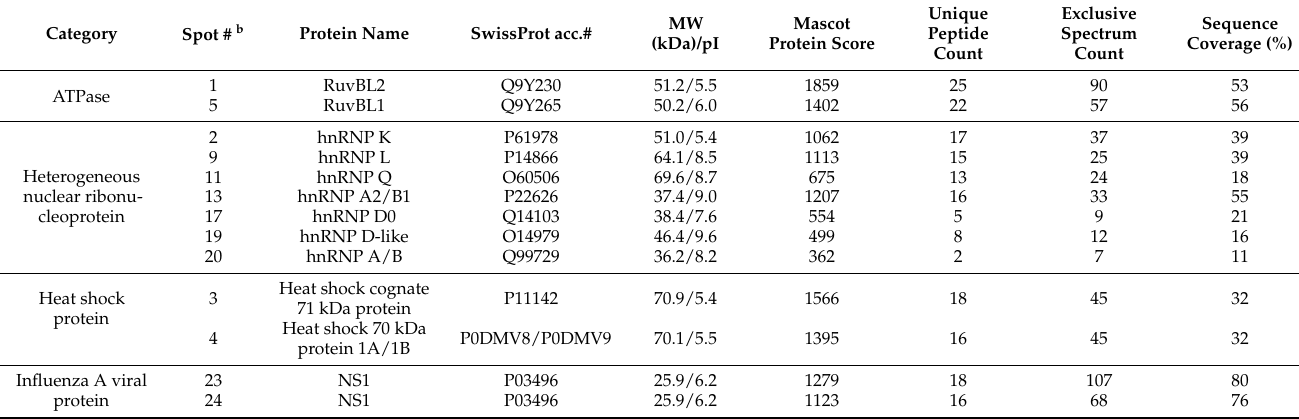
a If two or more proteins were identified in a 2-D gel spot, only the top one was listed in this table. If a protein was identified in two or more spots, only the one with higher or the highest abundance was listed here. Each identified protein contains at least two peptide matches that meet or exceed the threshold values for a 95% confidence level. Refer to Table S1 for the list of all the identified proteins. b Spot numbers correspond to those in Figure